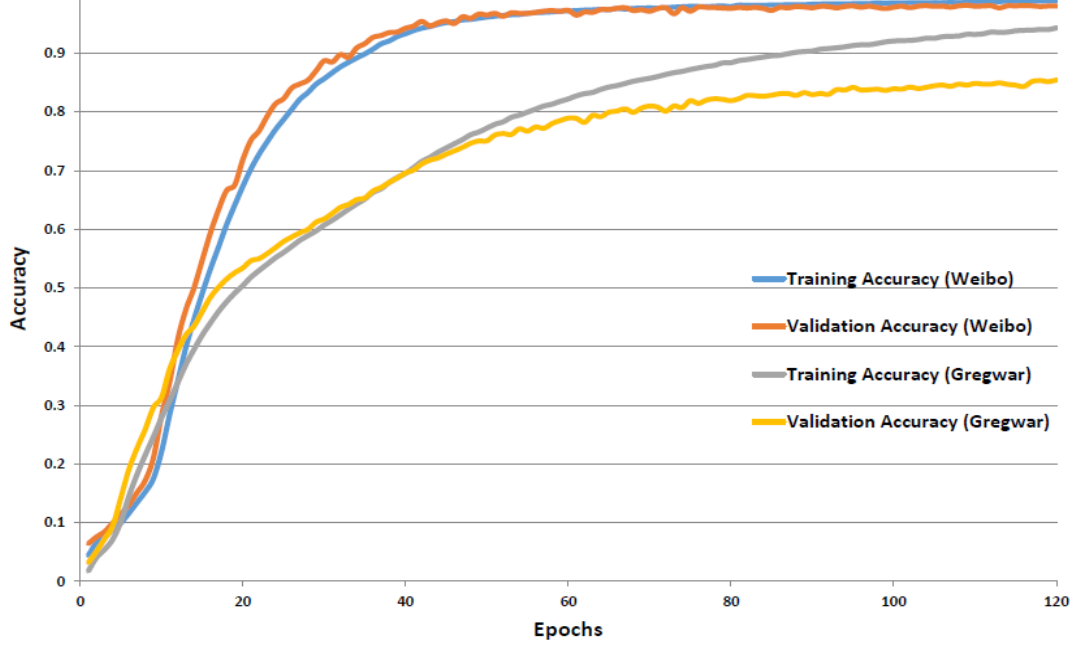
Figure 7. The training and validating total character recognition accuracies of CRABI-CNN on Weibo and Gregwar dataset